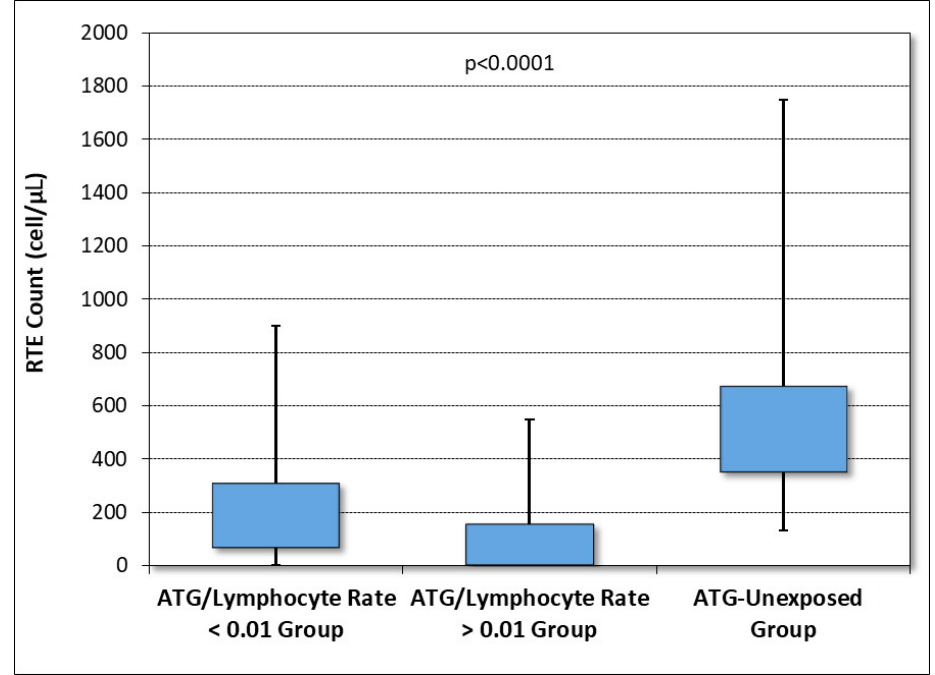
Figure 3. Box and whisker plot of recent thymic emigrant count (cell/μL) at one year after HSCT in the low ATG/lymphocyte ratio group (first box), high ATG/lymphocyte ratio group (second box), and ATG-unexposed group (third box).